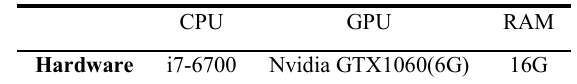
Table3.Hardware of the experimental platform